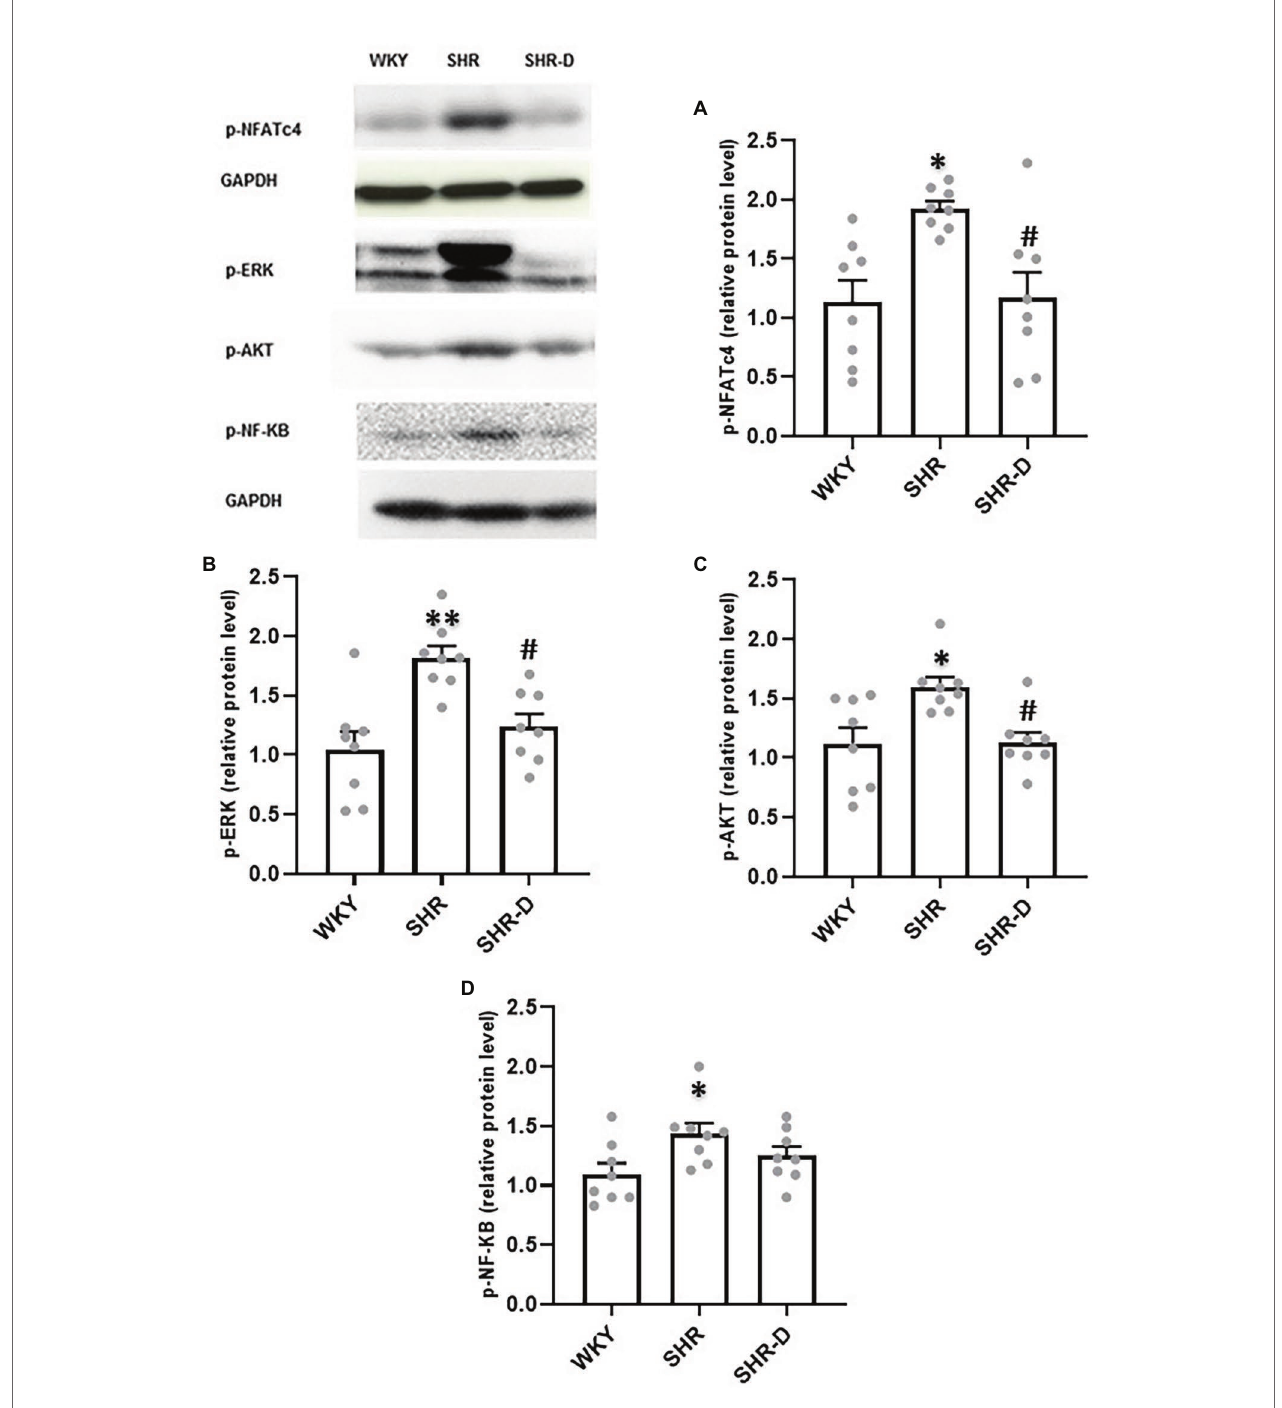
FIGURE 3 | Western blot analysis in the left ventricular myocardium. Representation of (A) p-NFATc4, (B) p-ERK1/2, (C) p-AKT, and (D) p-NF- κ B levels from WKY treated with vehicle, SHR treated with vehicle, and SHR-D. Statistically significant differences among WKY, SHR, and SHR-D are shown ( * p < 0.05 vs. WKY; ** p < 0.01 vs. WKY; and # p < 0.05 vs. SHR). Values are shown as mean ± SEM ( n = 8 per